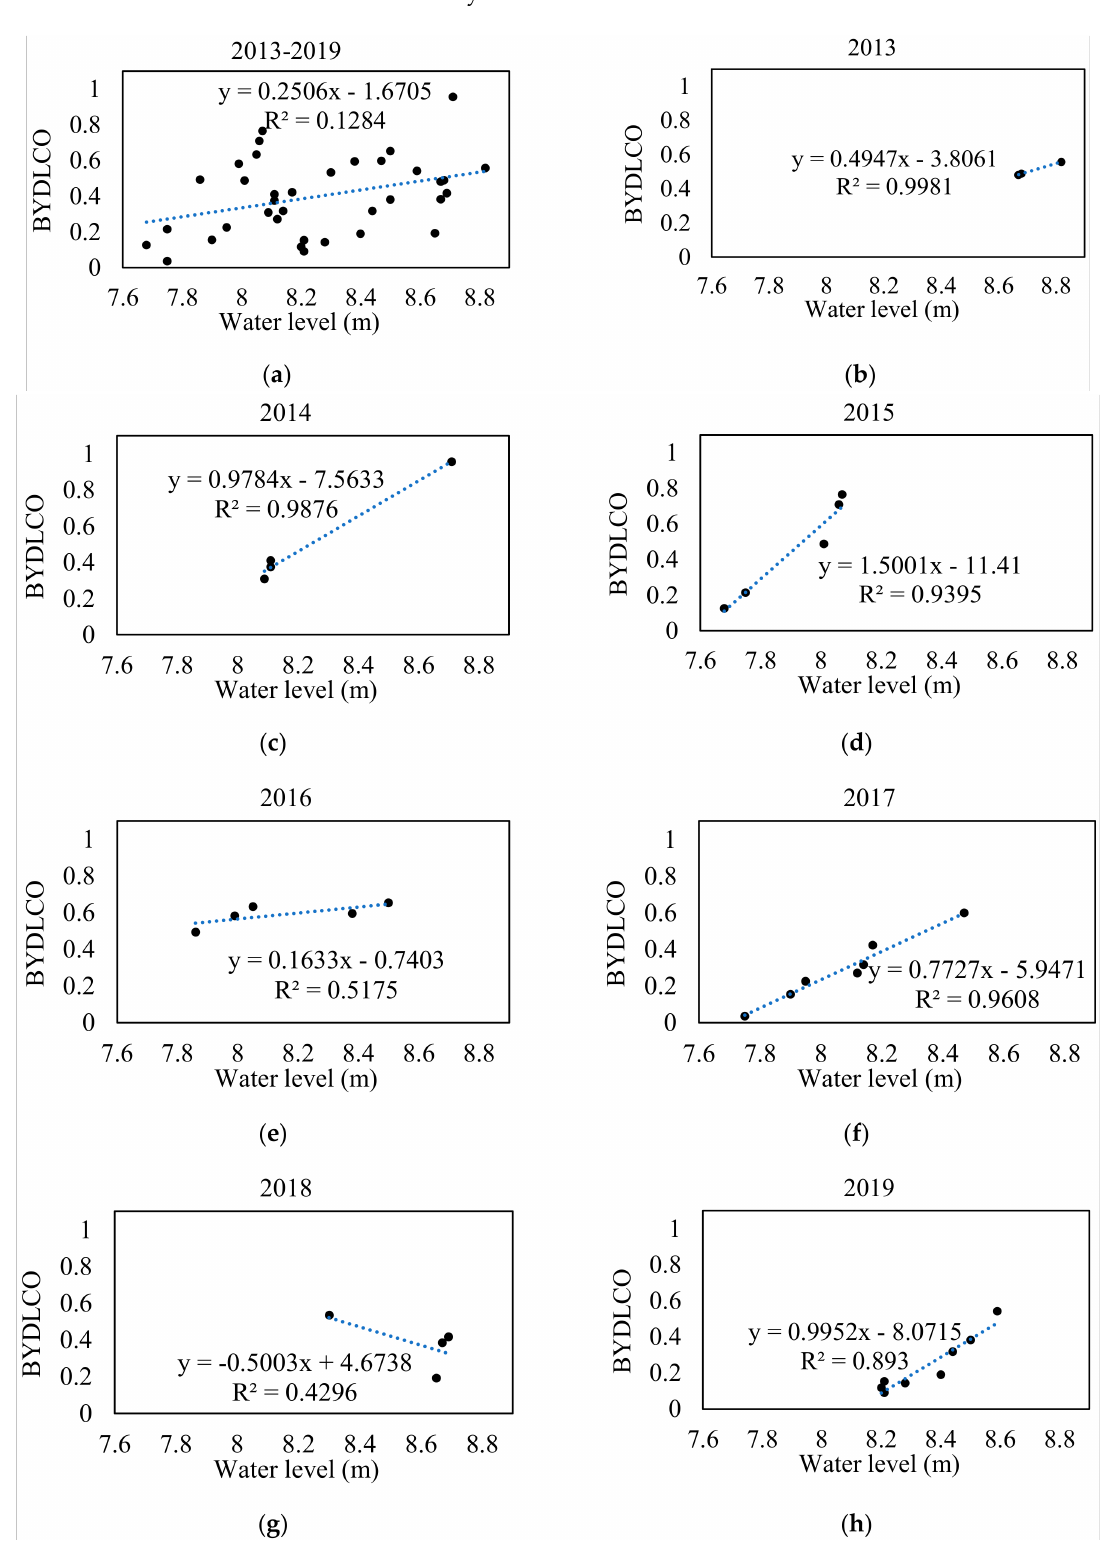
Figure 6. ( a ) Scatter plot of water level and BYDLCO index from 2013 to 2019; ( b–h ) scatter plots of water level and BYDLCO index during each